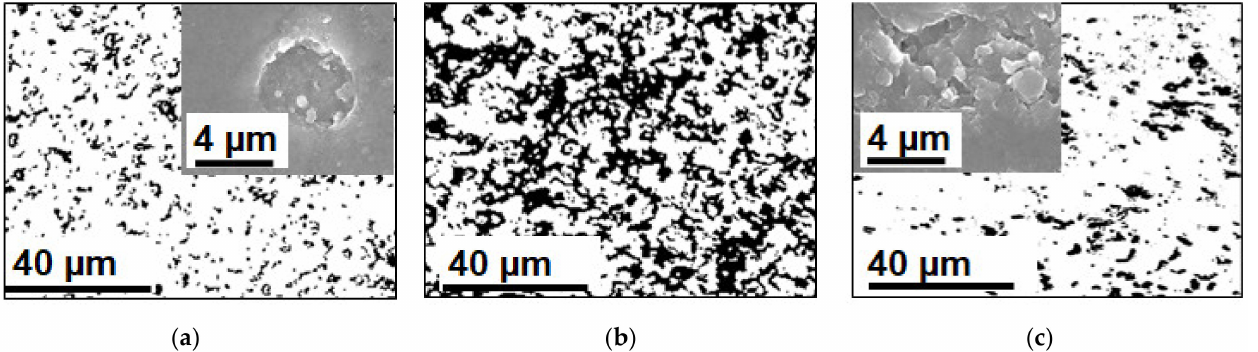
Figure 16. Contrasted optical images of swollen AMX-Sb membranes after 300 h of operation in ED desalination of 0.02 M NaCl ( a ), NaH 2 PO 4 ( b ) and NH 4 Cl ( c ) solutions. Black color corresponds to an inert binder PVC on the membrane surface. SEM images of the surface of dry membranes after 180 h of operation are presented in the